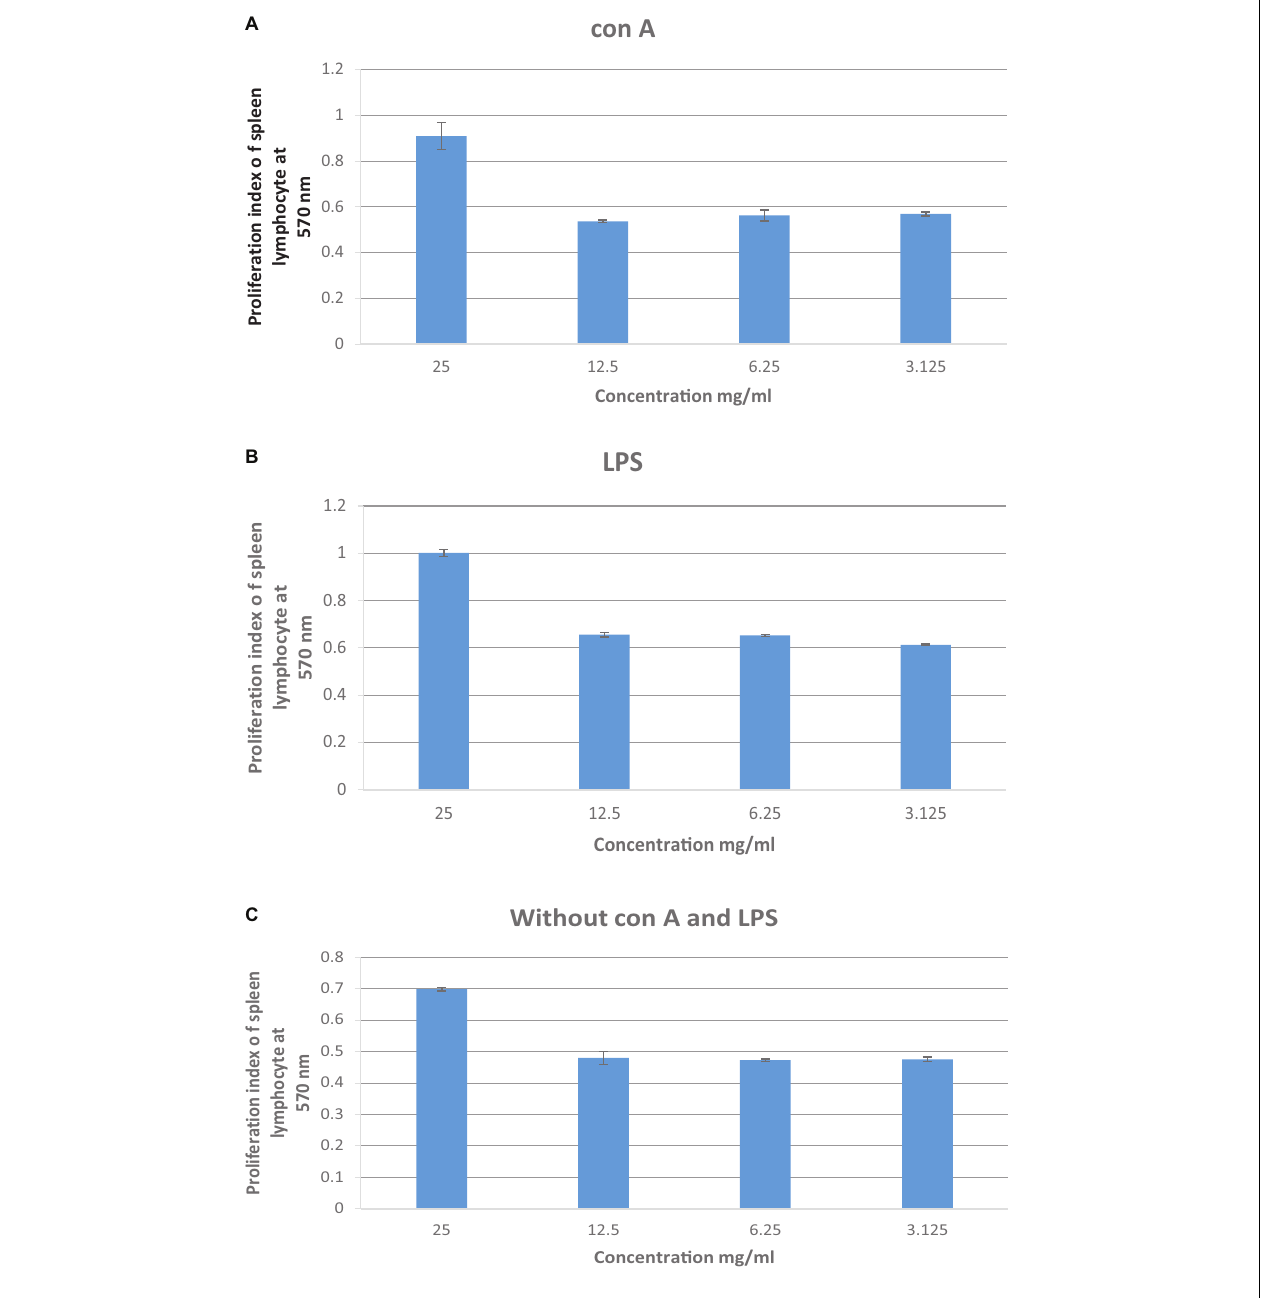
FIGURE 4 | (A) The effect of lemon and ginger combination water extract at various concentrations (25–3.125 mg/ml) on the proliferation index of splenic lymphocytes in the presence of Con A (2 µ g/ml). (B) The effect of lemon and ginger combination water extract at various concentrations (25–3.125 mg/ml) on the proliferation index of splenic lymphocytes in the presence of LPS (4 µ g/ml). (C) The effect of lemon and ginger combination water extract at various concentrations (25–3.125 mg/ml) on the proliferation index of splenic lymphocytes in the absence of mitogens. Results are expressed as means of three independent experiments (bars) ± SEM (lines). Proliferation index = treated cell absorbance/negative control absorbance.